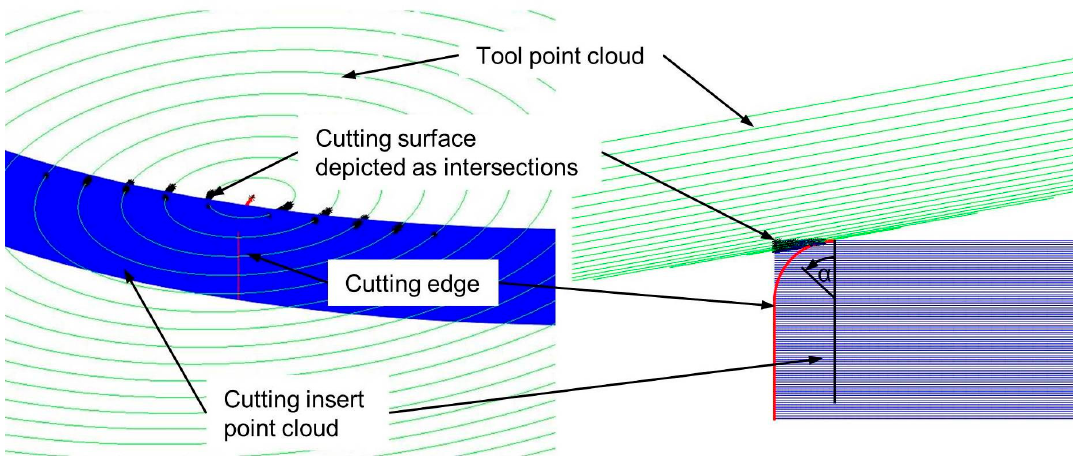
Figure 6. Intersection of tool and workpiece point clouds in one position on one tool path.